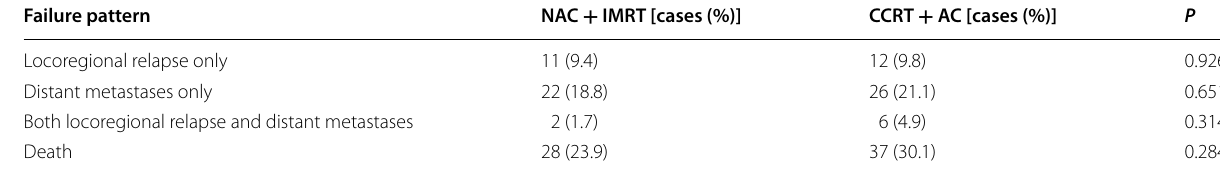
Table 2 Patterns of disease failure in patients treated with NAC plus IMRT vs. CCRT plus